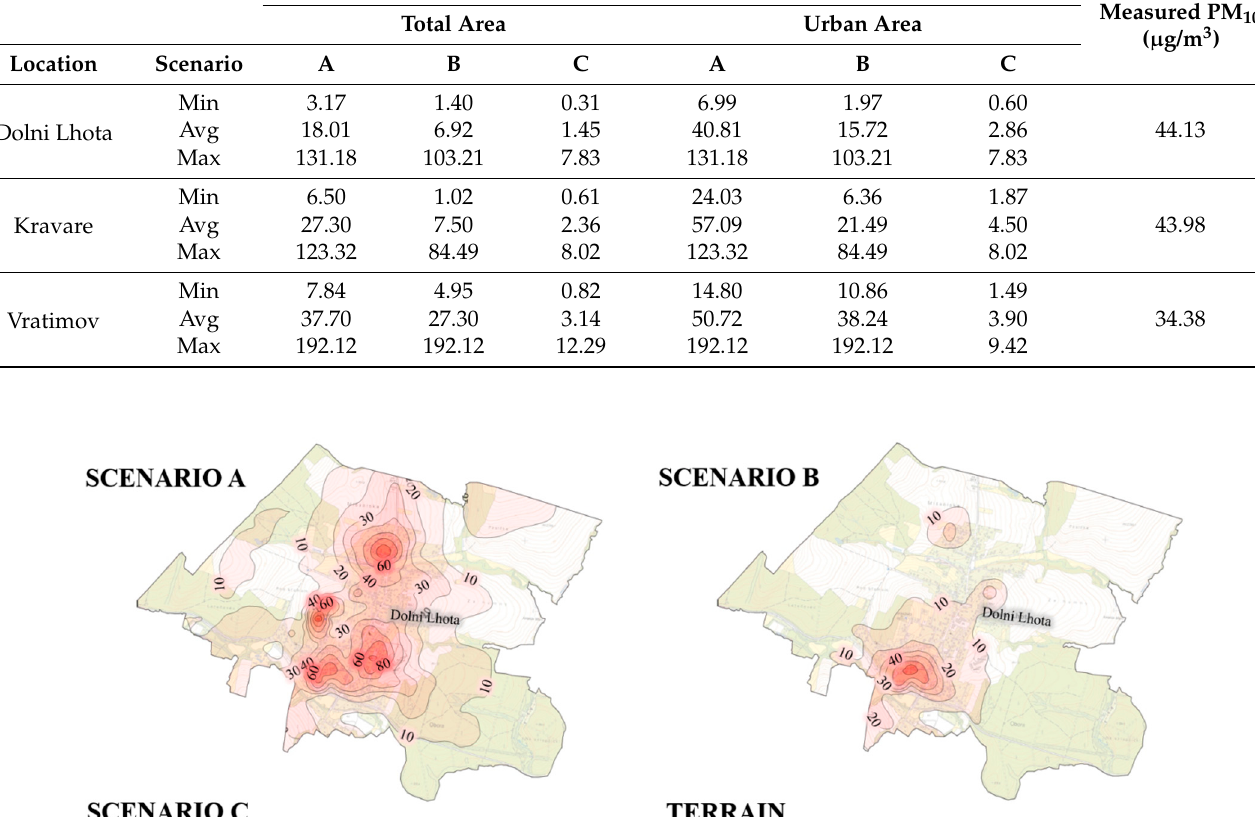
Table 3. Minimum, average and maximum daily concentrations of PM 10 for all three model scenarios and measured aver- age concentrations.